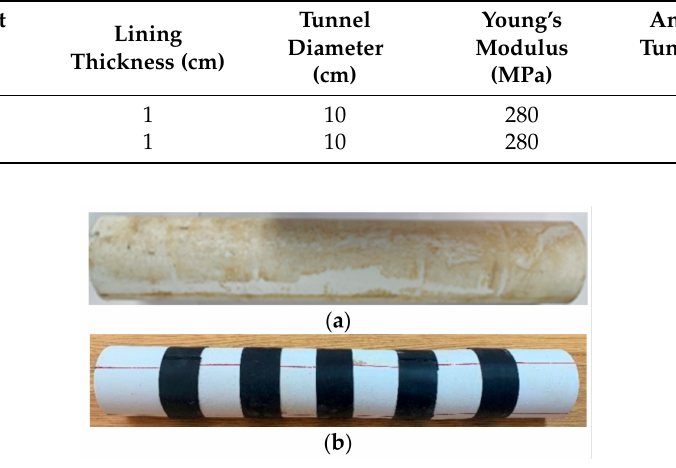
Figure 5. Tunnel models. ( a ) lining without joints; ( b ) lining with